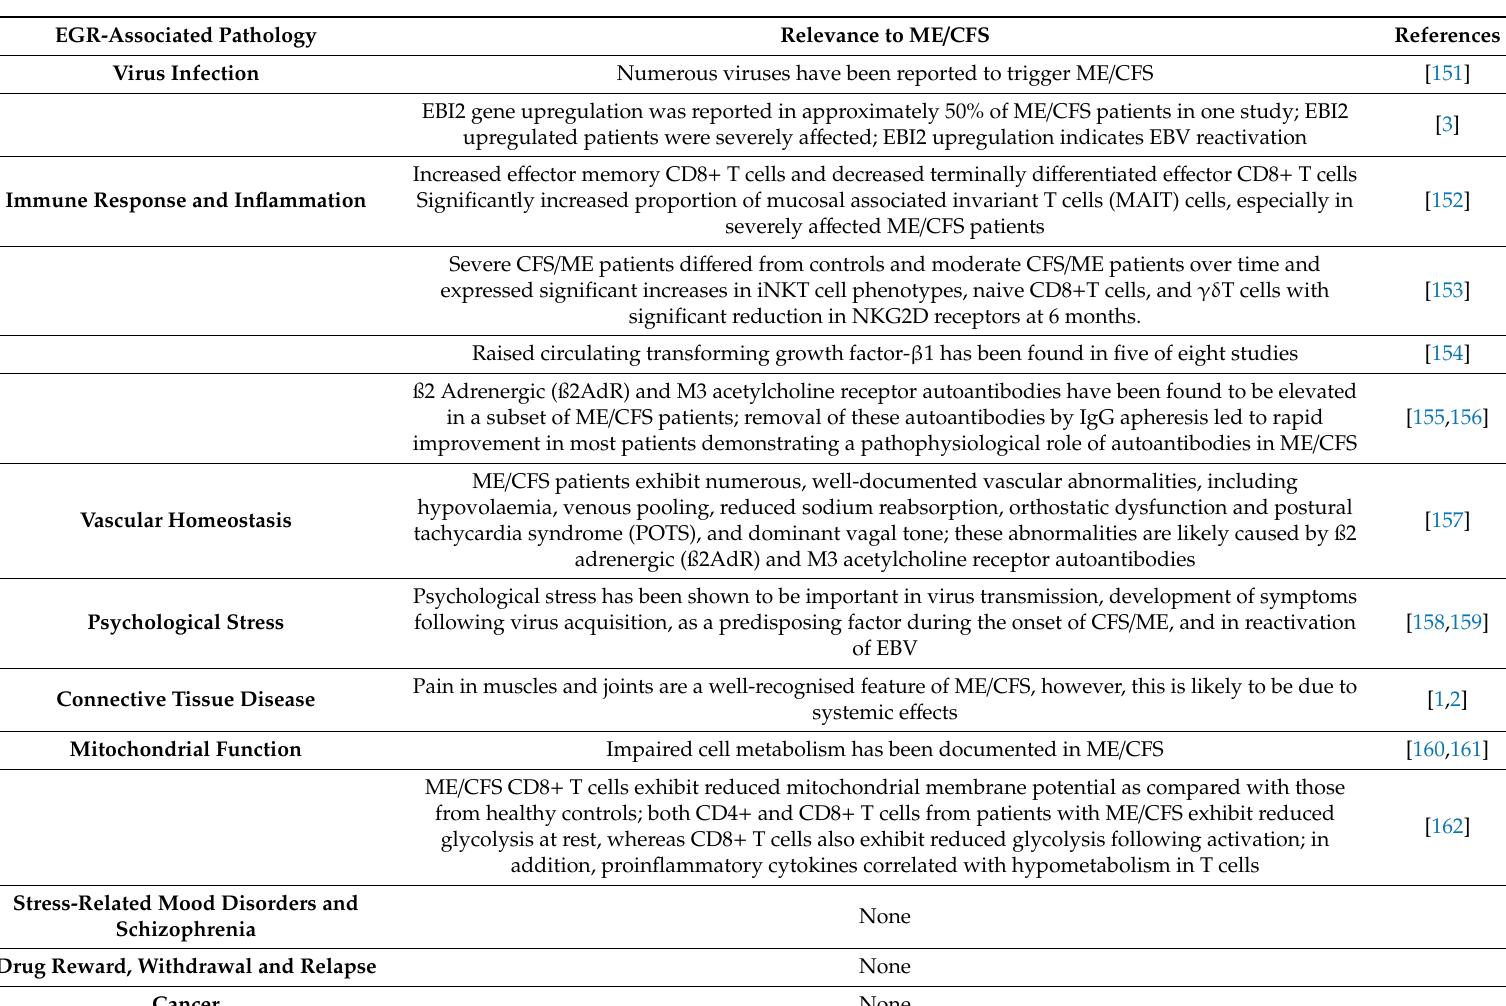
Table 4. Relevance of EGR-Associated Pathology to Myalgic Encephalomyelitis / Chronic Fatigue Syndrome (ME /